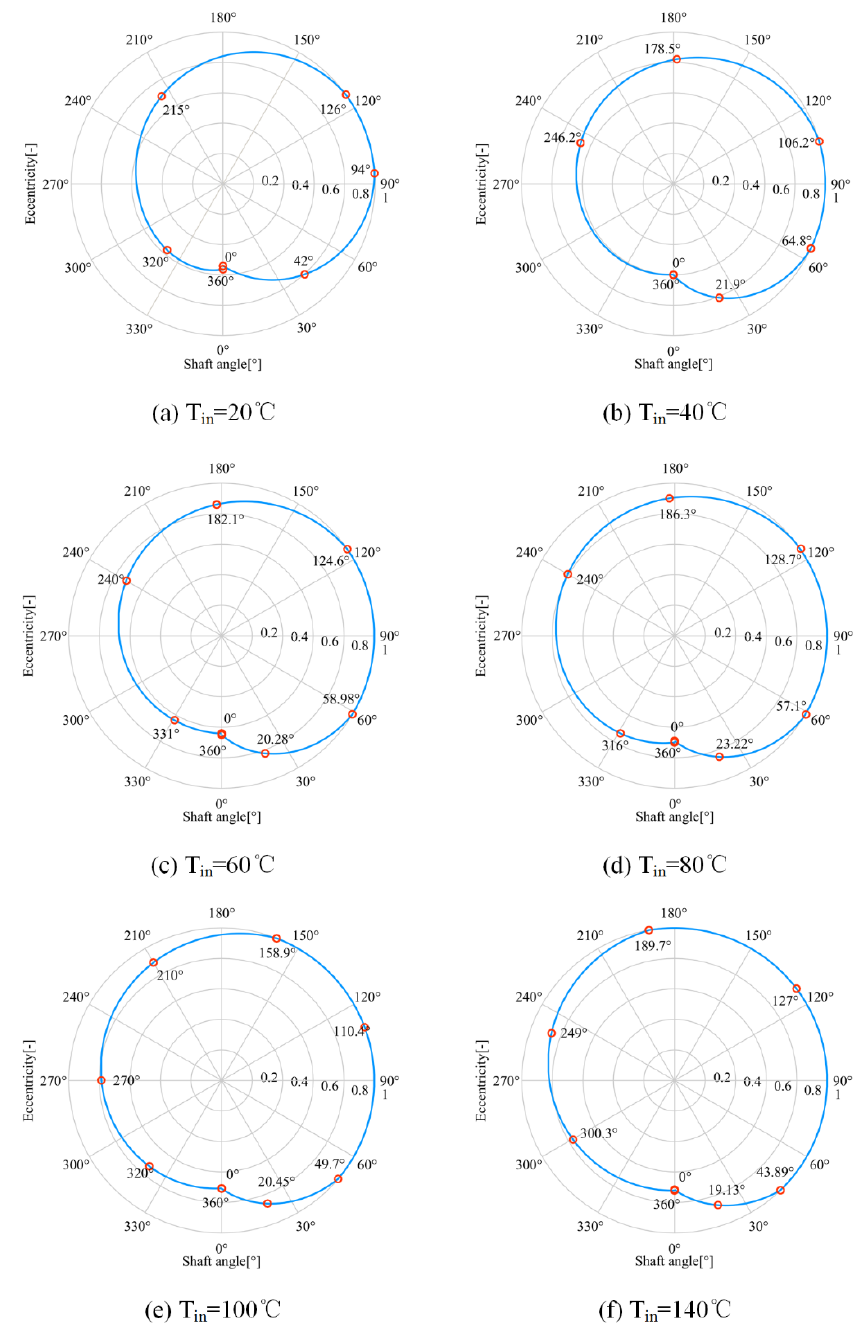
Figure 10. Simulated trajectory of the piston bottom in the cavity over one shaft revolution with different inlet temperatures.